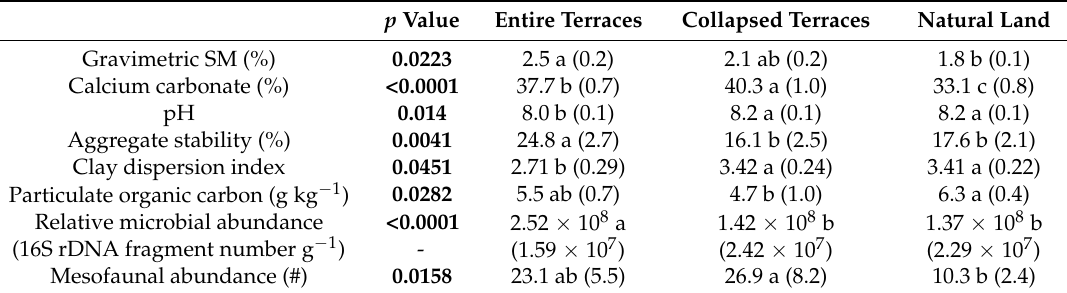
Table 2. Land-use and terrace-state effect on soil